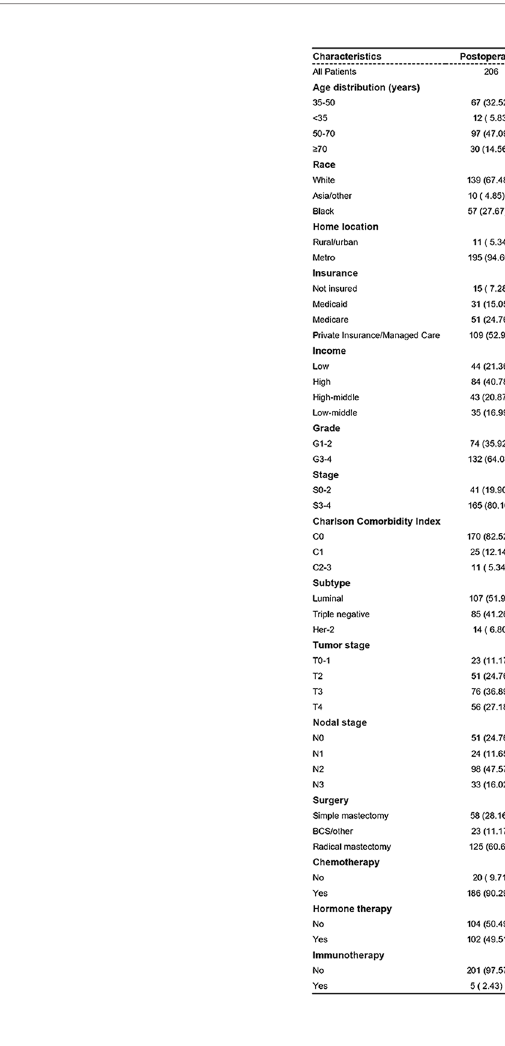
FIGURE 3 | Subgroup analyses of radiotherapy treatment based on matched population. BCS, breast-conserving surgery; HR, hazard